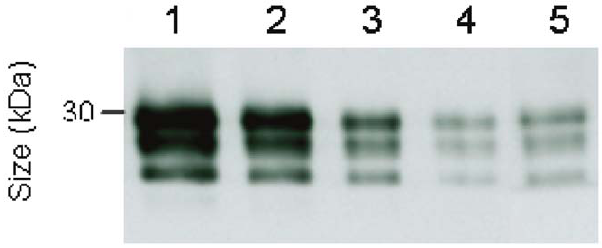
Figure 1. Recovery of PrP TSE after extraction from muscle tissue. Western blot detection of PrP27-30, the Proteinase K-resistant core of PrP TSE , after labelling with anti-PrP monoclonal antibody ICSM- 18. Lanes 1–4; Proteinase K-digested brain homogenates from WTD in the clinical stage of CWD representing 5 6 10 2 5 g (lane 1), 1 6 10 2 5 g (lane 2), 5 6 10 2 6 g (lane 3) and 1 6 10 2 6 g (lane 4) of CWD brain tissue. Lane 5; PrP TSE extract from 100 mg of skeletal muscle ( M. glutaeobiceps ) from an uninfected control WTD (blotted also in lane 9 of figure 2; Fa- WTD 10) spiked before extraction with 1 6 10 2 5 g of CWD brain tissue from a WTD in the clinical stage of disease.